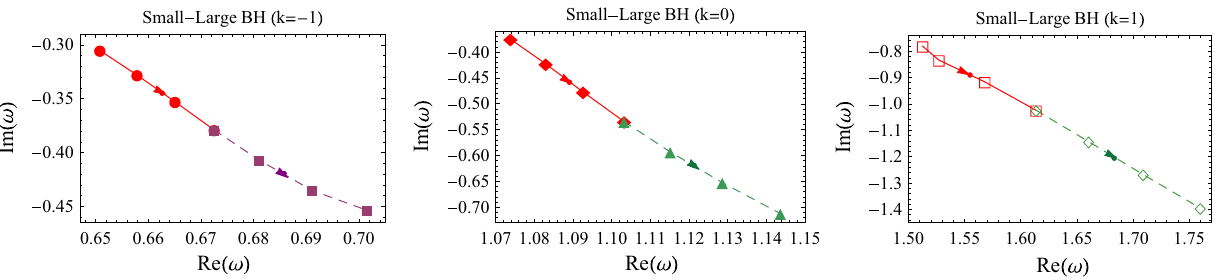
Fig. 3 The behavior of QNM frequencies for large and small black holes in the isobaric process. The arrow indicates the increase of the black hole horizon